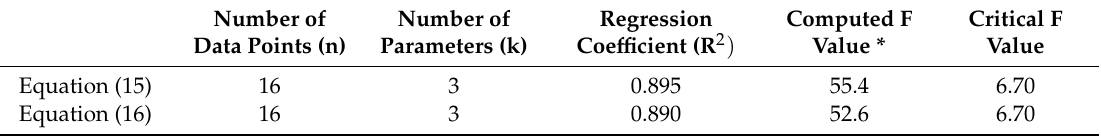
Table 3. The computed F values and the corresponding critical F values for Equations (15) and (16) based on the 99% confidence interval according to the global